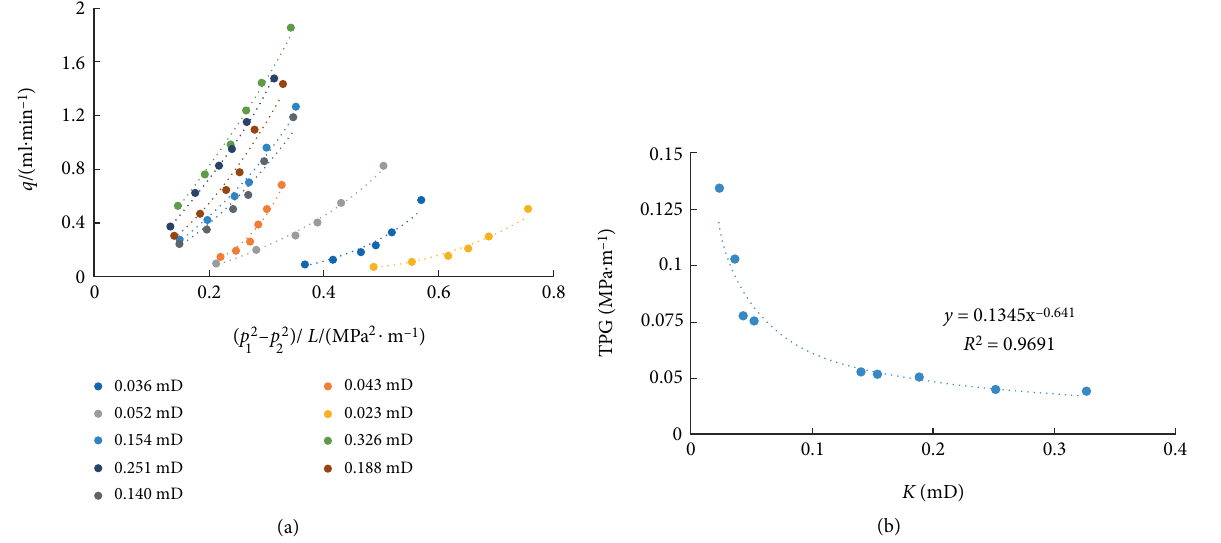
Figure 4: (a) Relationship between gas flow rate and pressure square difference under different permeability. (b) The correlation between permeability and TPG.